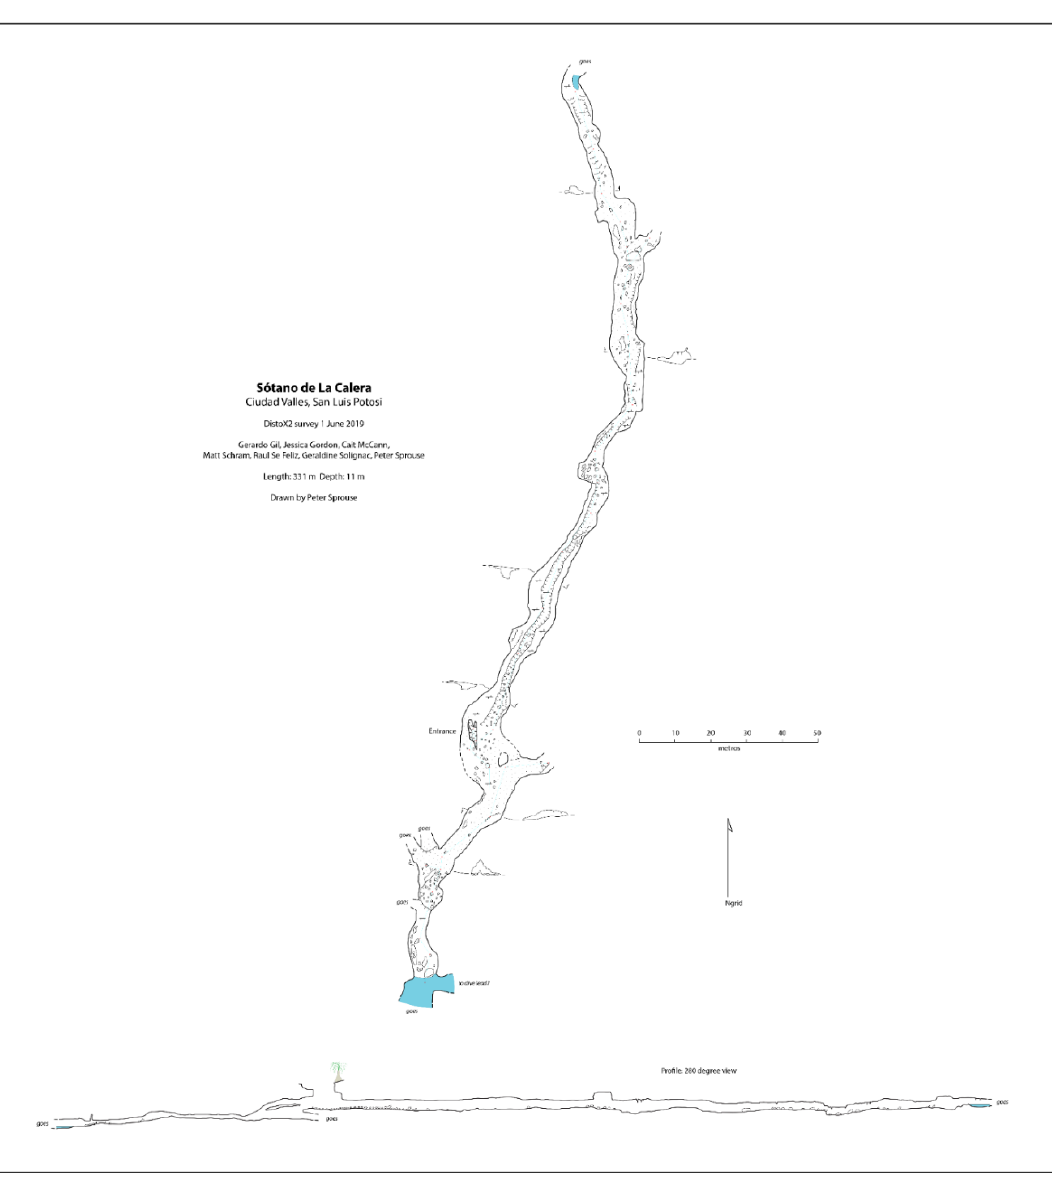
Figure 7. Map of Sótano de La Calera. During the dry season, galleries contain many pools, some inhabited by Astyanax fish. During the rainy season it becomes a flowing stream and fish can freely swim along its galleries and to Sótano del Toro and Sótano del Toro #2 The entrances to S ó tano del Toro #2 and S ó tano de La Calera are only 239 m from each